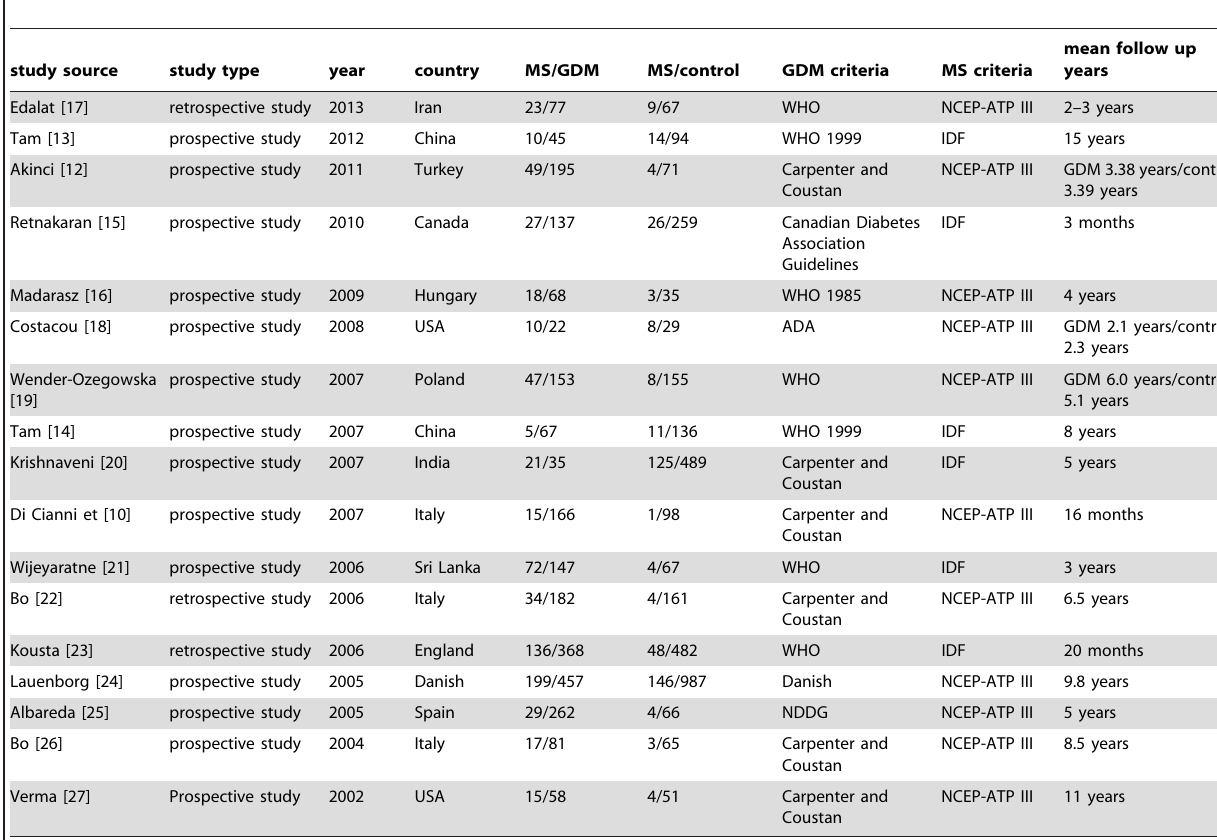
Table 1. Characteristics of the studies included in this